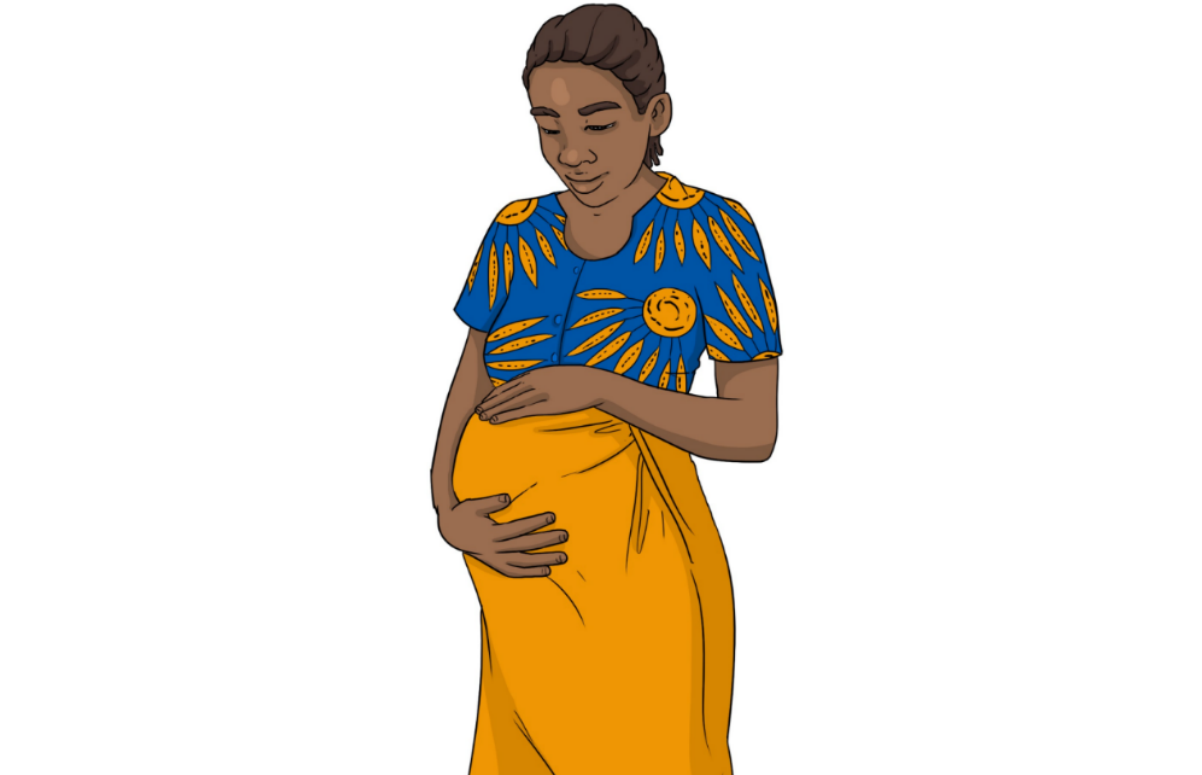
Figure 3. Farida after